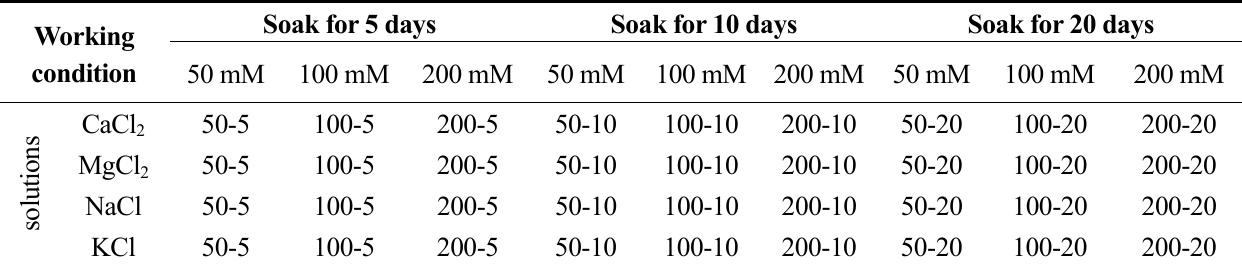
Table 2. Working condition of GCL